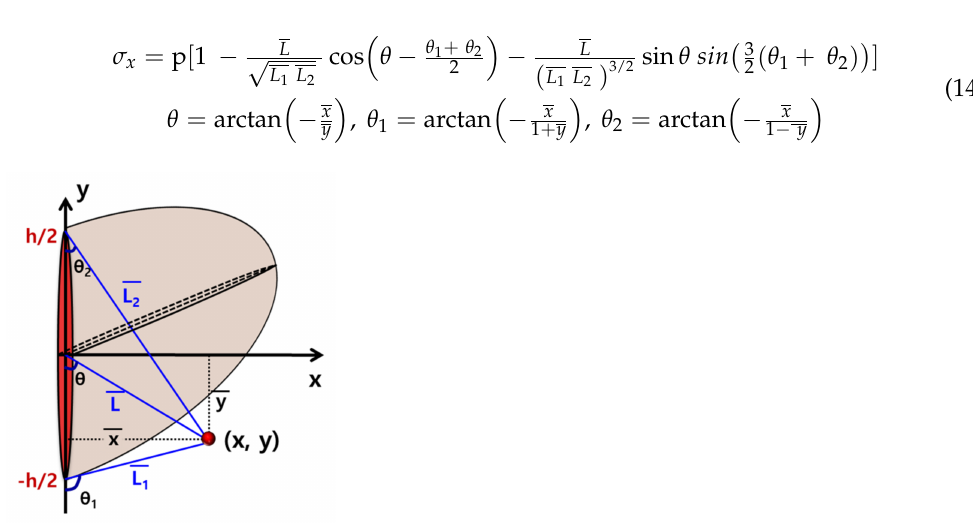
Figure 6. Position (x, y) influenced by stress shadow of 2D fracture.